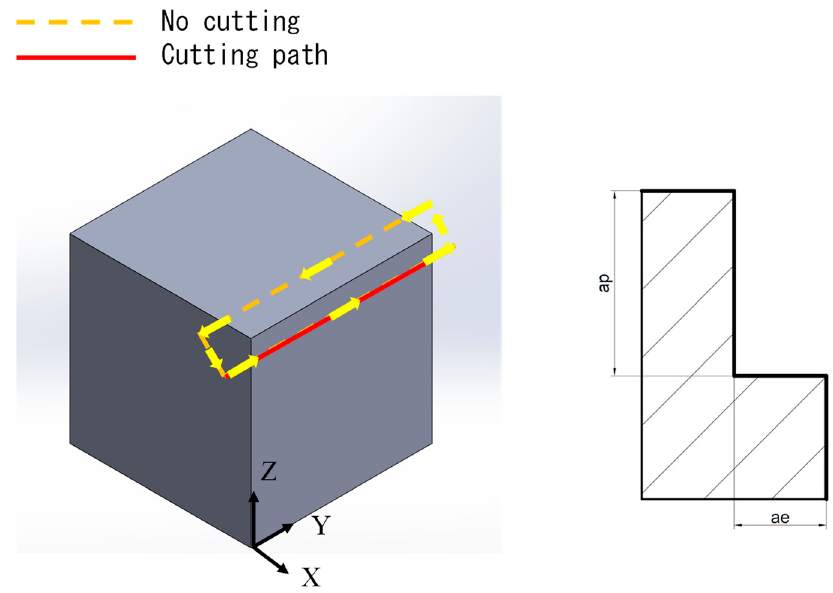
Figure 18. Cutting Figure 18. Cu tt ing conditions.